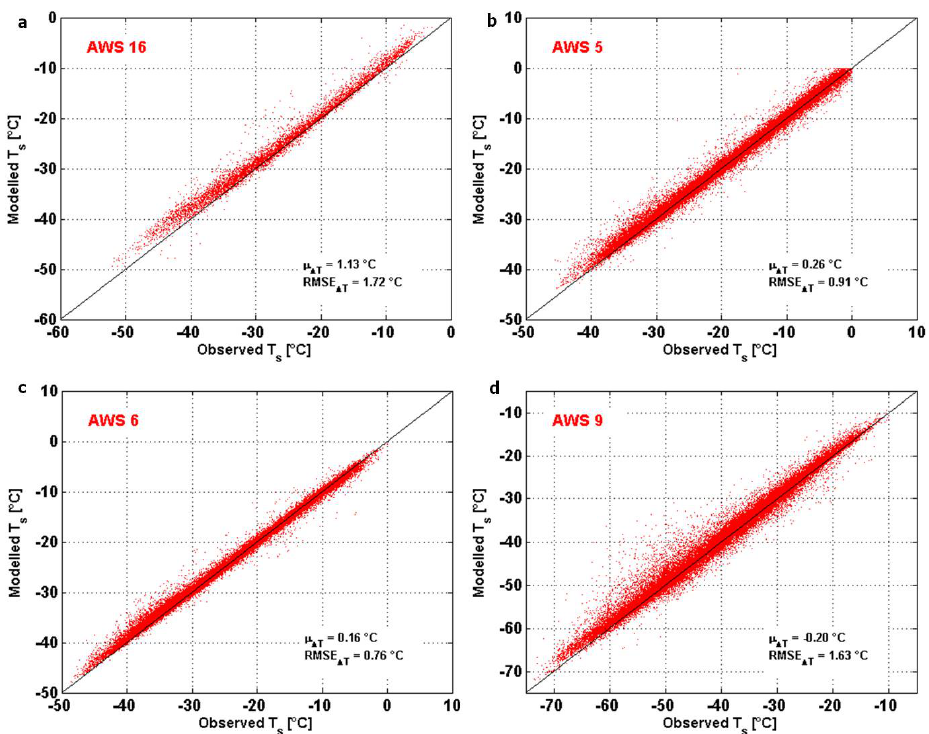
Fig. 2. Observed versus modelled surface temperature T s (2 hour averages), varying time periods, at (a) AWS 16 – Princess Elisabeth, (b) AWS 5 – Wasa/Aboa, (c) AWS 6 – Svea Cross, and (d) AWS 9 – Kohnen. Note the different axes’ ranges. µ 1T presents the mean surface temperature difference and RMSE 1T the root mean squared error of the surface temperature